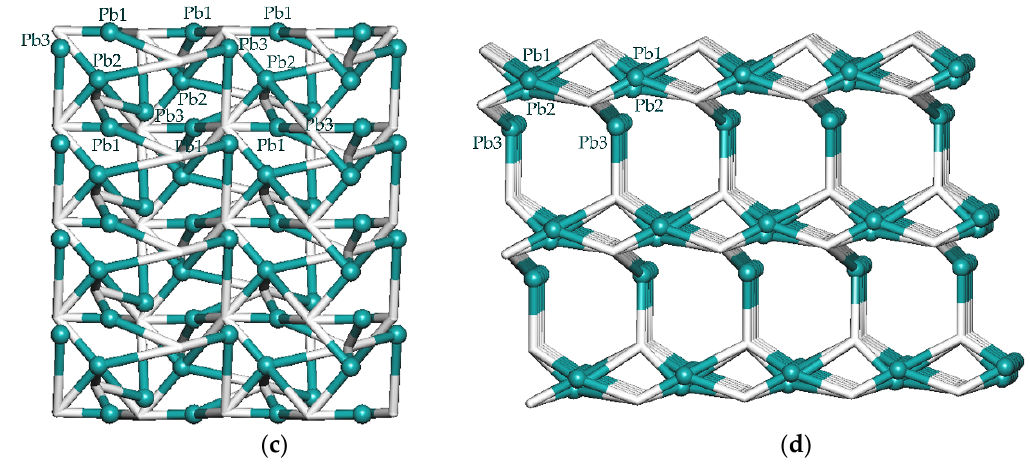
Figure 1. Structural fragments of 1. ( a ) Coordination environment around the Pb(II) atoms; H atoms are omitted for clarity. Symmetry code: i = x + 1/2, − y , z + 1/2; ii = x , y + 1, z ; iii = x + 1/2, − y − 1, z + 1/2; iv = x , y − 1, z ; v = x − 1/2, − y , z + 1/2. ( b ) 3D coordination polymer seen along the b axis. ( c , d ) Topological representation of an underlying tetranodal 4,5,5,6 ‐ connected net with the unique topology; views along the c ( c ) and b ( d ) axis. Color codes: 2 ‐ , 4 ‐ , and 5 ‐ connected Pb centers (turquoise balls; Pb3, Pb1, and Pb2, respectively; partial labelling scheme is shown), centroids of 5 ‐ and 6 ‐ connected cpta 3 − blocks (gray).